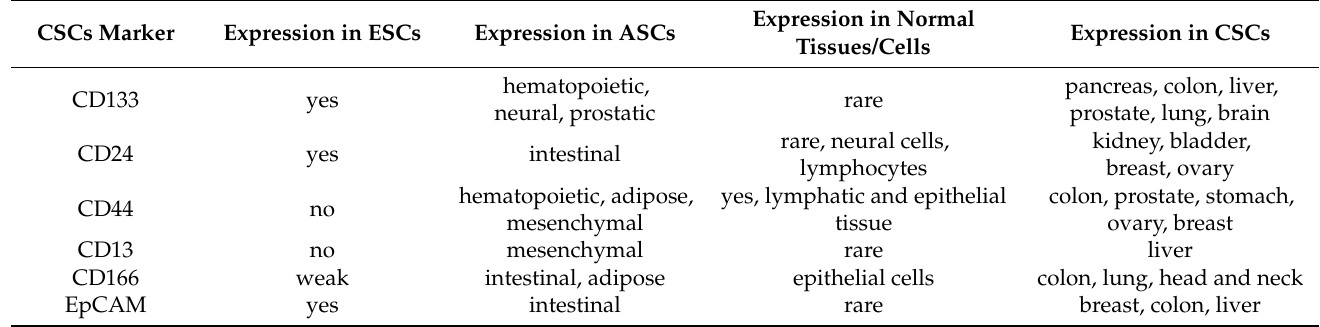
Table 2. The most common surface markers of